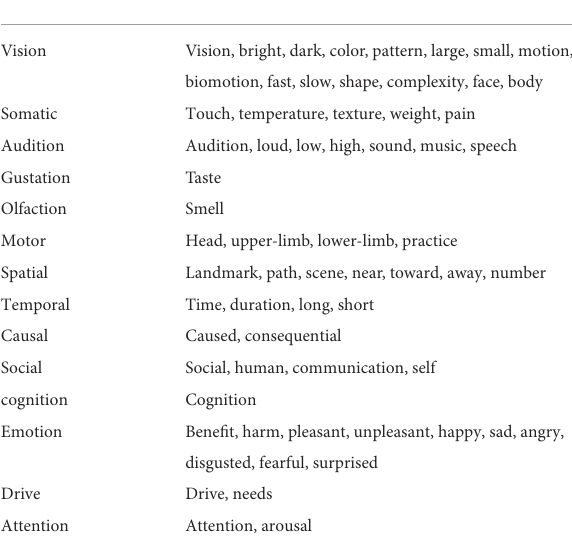
TABLE 4 Sixty-five attributes used in Binder et al.’s (2016) conceptual representation.